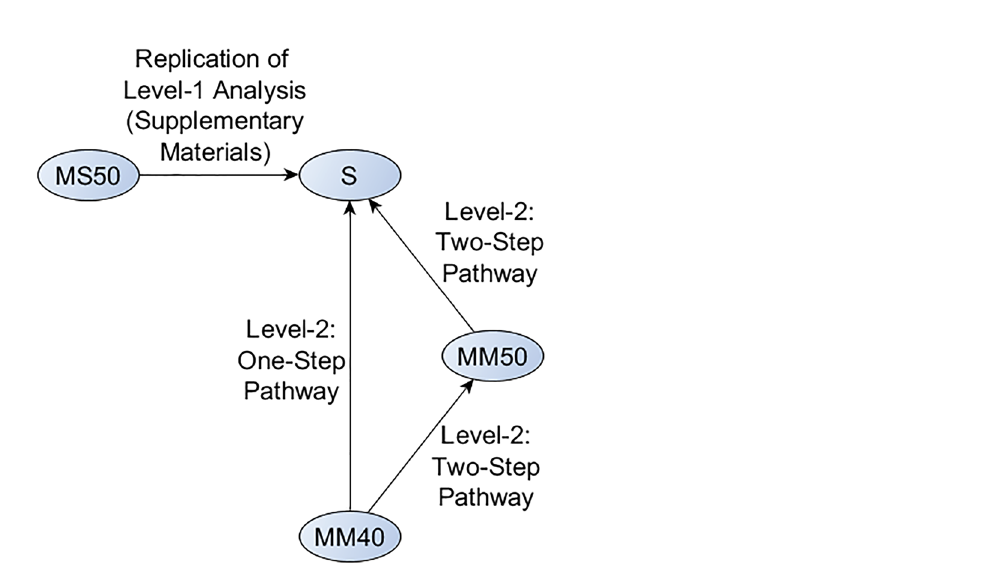
Figure 1. Illustration of the One-Step and Two-Step regression pathways compared in this